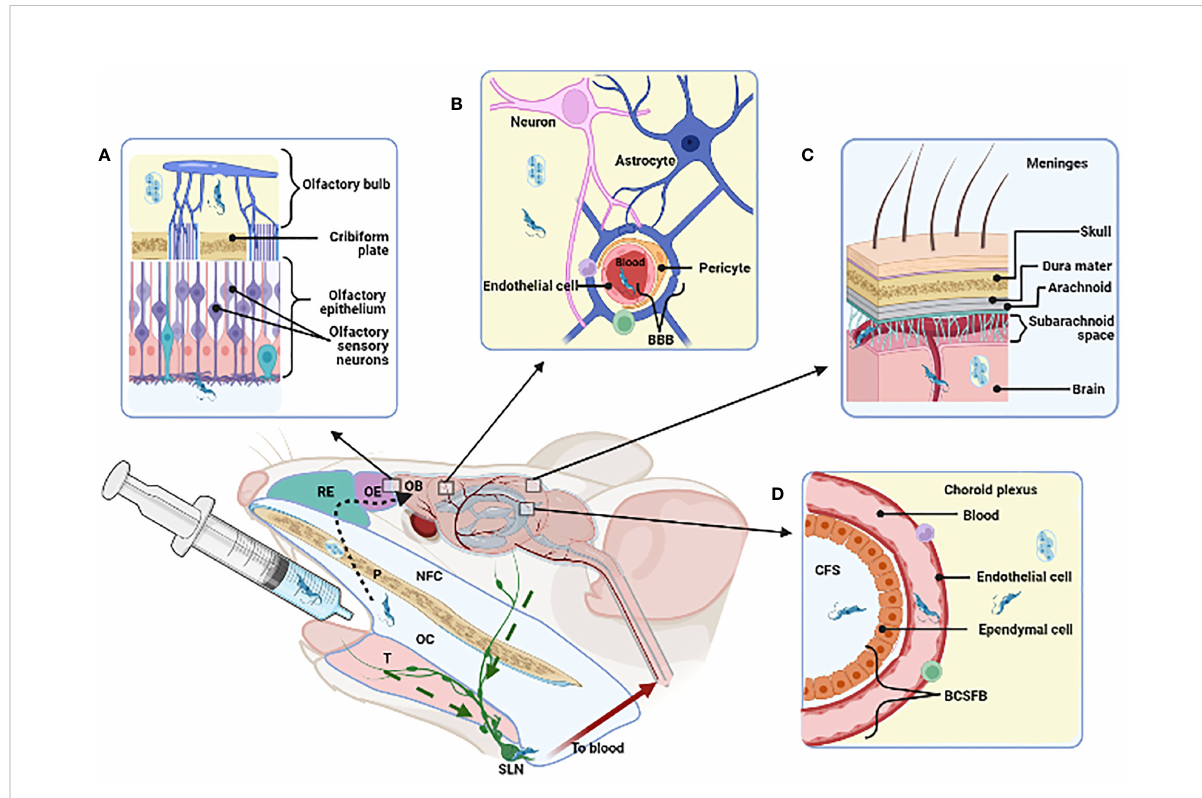
FIGURE 2 Strategies that T. cruzi may use for reaching and invading the Central Nervous System and possible dissemination following oral cavity (OC) infection. The fi gure stands for murine experimental oral infection. Accordingly, after delivering the parasites into de oral cavity, they may take the following pathway(s): 1) olfactory way ( A , dotted arrow), traversing the palate (P), nasopharyngeal cavity (NFC), respiratory and olfactory epithelia (RE, OE) reaching the olfactory bulb (OB); 2) disrupture of the blood brain barrier (BBB) in the parenchyma (B) or in the meninges (C)